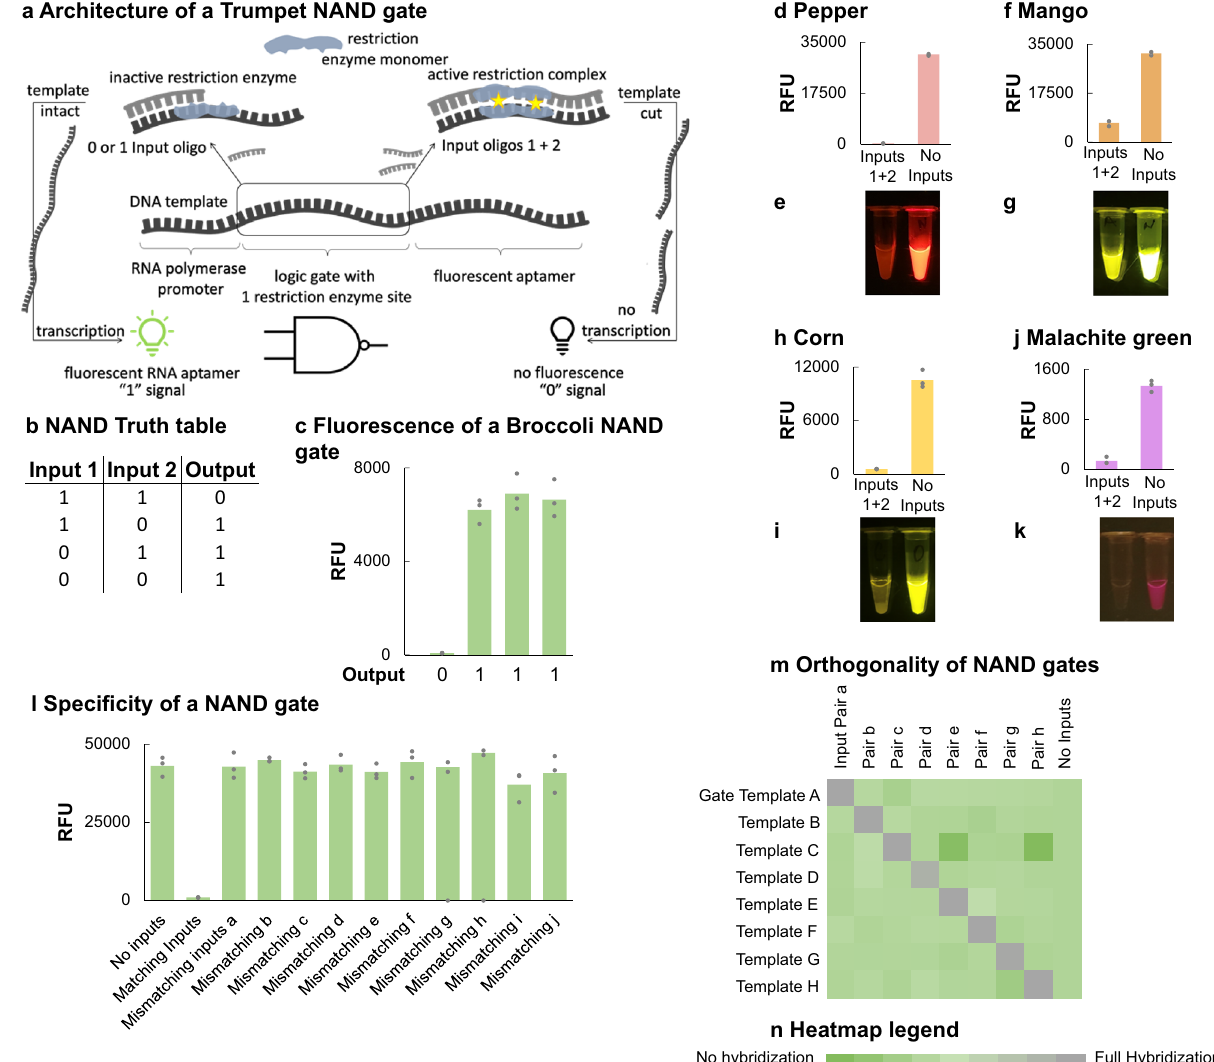
Fig. 1 | Trumpet NAND gates. a The general architecture of a NAND gate. b A typical NAND gate truth table. c Fluorescence results of a NAND gate. When no inputs, Input 1, or Input 2 hybridize with the gate template, the template remains intact and the results are a 1 when Broccoli, the encoded RNA aptamer, is tran- scribed. When both inputs hybridize with the gate template simultaneously, the template is cut by the restriction enzyme and Broccoli is not transcribed. This results in a 0, a lack of signal. d Fluorescence results of a NAND gate transcribing Pepper aptamer. e Visual results of the signals shown in ( d ). f Fluorescence results of a NAND gate transcribing Mango aptamer, which binds TO1-PEG-biotin as the ligand. g Visualresultsofthesignalsshownin( f ). h FluorescenceresultsofaNAND gate transcribing Cornaptamer,whichbinds DFHOas the ligand. i Visualresults of the signals shown in ( h ). j Fluorescence results of a NAND gate transcribing Mala- chite Green aptamer, which binds Malachite Green Ligand. k Visual results of the